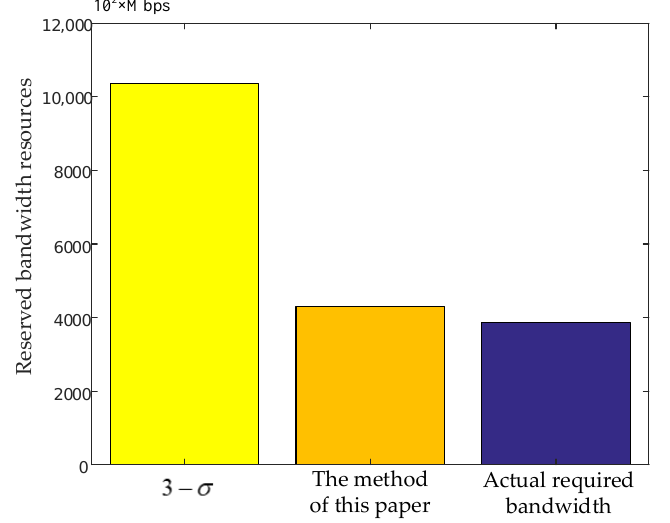
Figure 5. Comparison of resource consumption with different processing methods. The blue and red lines in Figure 6 represent the actual traffic and the predicted traffic after processing, respectively. It can be seen that the predicted traffic after processing is always higher than the actual traffic, which achieves a good resource reservation effect and is beneficial to the improvement of service availability.